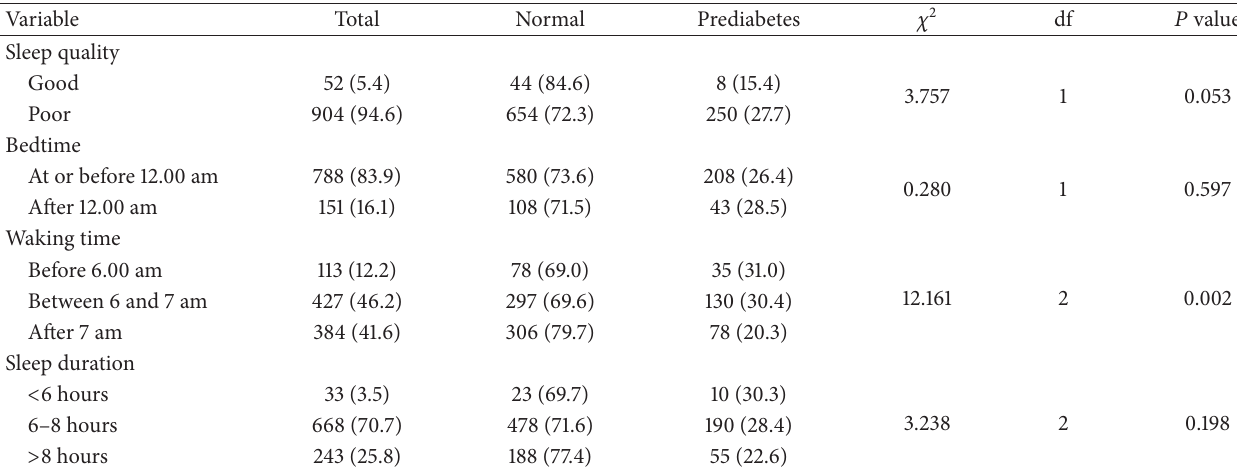
Table 2: Relationship between sleep patterns and prediabetes.